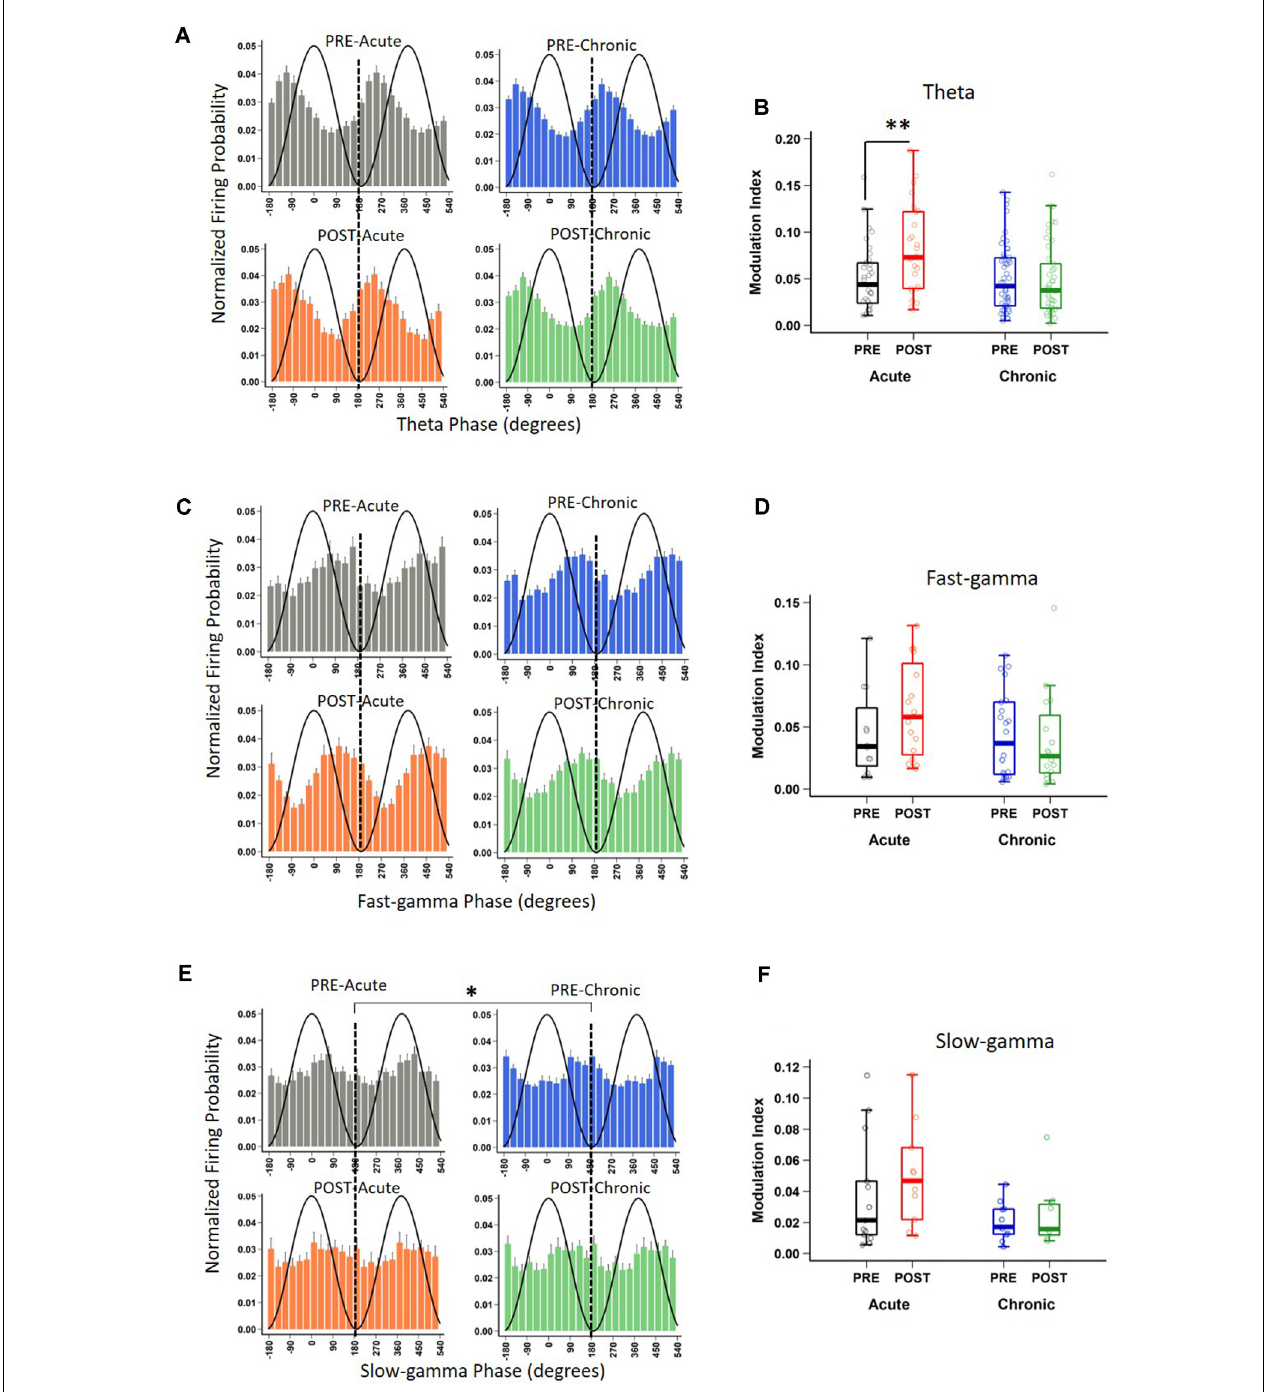
FIGURE 3 | Impact of stress on phase-locking properties of CA1 place cells to theta and gamma oscillations. (A) The spiking probability plotted as a function of the phase of theta for significantly theta-modulated place cell populations (Rayleigh p < 0.05). Population spiking probability is elevated around the trough and ascending phase of theta (0/360 ◦ set for theta peak, 180 ◦ for theta trough). (B) The strength of theta-phase locking (Modulation index, MI) is altered by stress [LMMs: main effect of day, F (1,155) = 1.892, p = 0.171; main effect of session, F (1,155) = 5.425, p = 0.022; interaction, F (1,155) = 5.702, p = 0.018); post hoc Tukey’s test, PRE-Acute ( n = 35) vs. POST-Acute ( n = 26), p = 0.006, POST-Acute ( n = 26) vs. POST-Chronic ( n = 45), p = 0.038]. (C) The spiking probability plotted as a function of the phase of fast-gamma (FG) for significantly FG-modulated place cell populations (Rayleigh p < 0.05) is elevated around the trough and descending phase of FG (0/360 ◦ set for FG peak, 180 ◦ for FG trough) but stress did not affect this phase relationship: (FG, Circular ANOVA, F (3,62) = 0.919, p = 0.437). (D) The